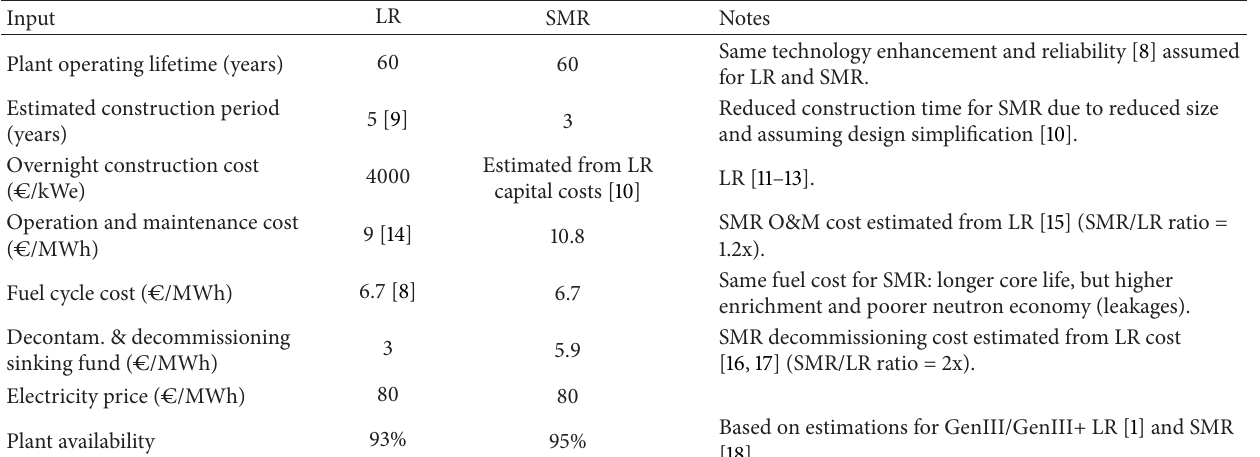
Table 1: Scenario input data to INCAS test cases.